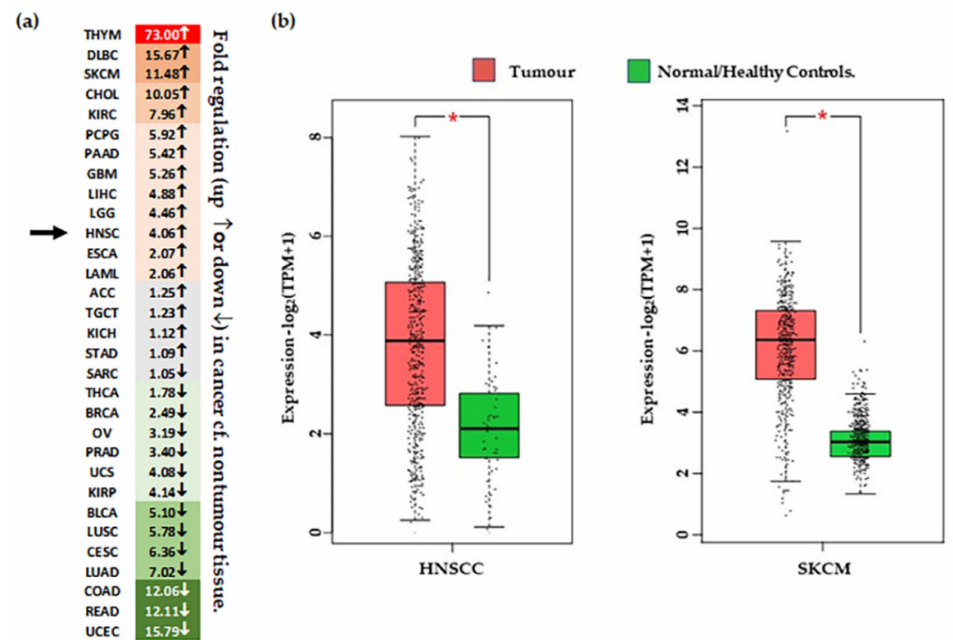
Figure 3. Differential expression of CSPG4 in tumour tissue. ( a ) Heat map of ‘fold’ difference (up ↑ , or down ↓ ) between control and tumour tissue across different malignancies. See abbreviations below. Green represents down regulated gene expression compared to normal (noncancer) tissue and red rep- resents increased expression compared with normal (noncancer tissues). Grey indicates a difference that is minor (<1.5-fold up or down). Arrows indicated fold change in HNSCC. ( b ) CSPG4 expression in HNSCC [Left, n (tumour tissue) = 519 & n (/healthy tissue) = 44], and melanoma [Right, n (tumour tissue) = 461 & n (normal/healthy tissue) = 558]. Shown, significantly higher expression of CSPG4 in HNSCCs and melanoma compared with healthy tissues (by one-way ANOVA, α = 0.01, * p < 0.01). Data (transcripts per million/TPM) is transformed [log 2 (TPM+1)], and represented as box